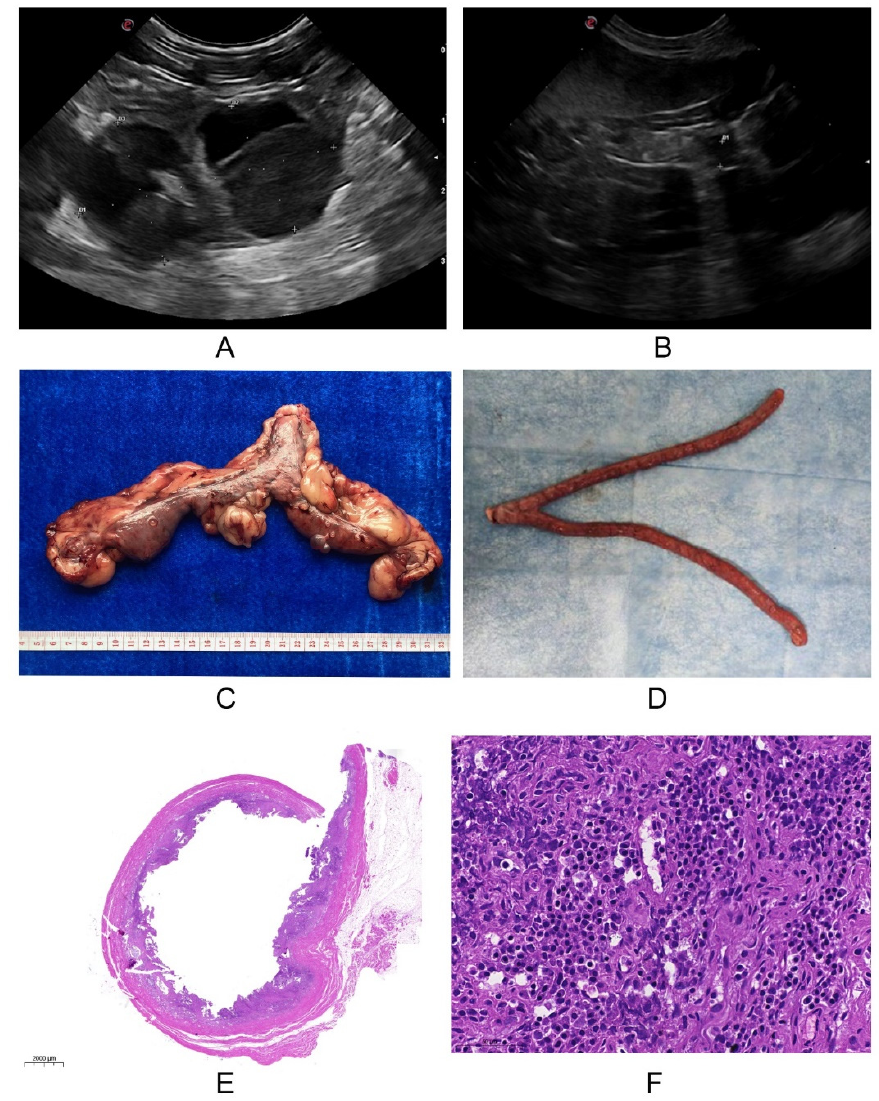
Figure 1. The clinical examinations of dogs. ( A , B ). Ultrasonography examination: the irregular and hypertrophic endometrium and fluid-filled uterine body were observed in dogs with pyometra ( A ) compared with that in healthy dogs ( B ); ( C , D ). The uterine examination: the fluid filled in the uteruses of dogs suffering from pyometra ( C ), but not in the healthy dogs ( D ); ( E , F ). Histopathological examination: severe endometrial gland hyperplasia ( E ) and the inflammatory cells (lymphocytes, plasma cells) endometrial infiltration ( F ) presented in the diseased group.